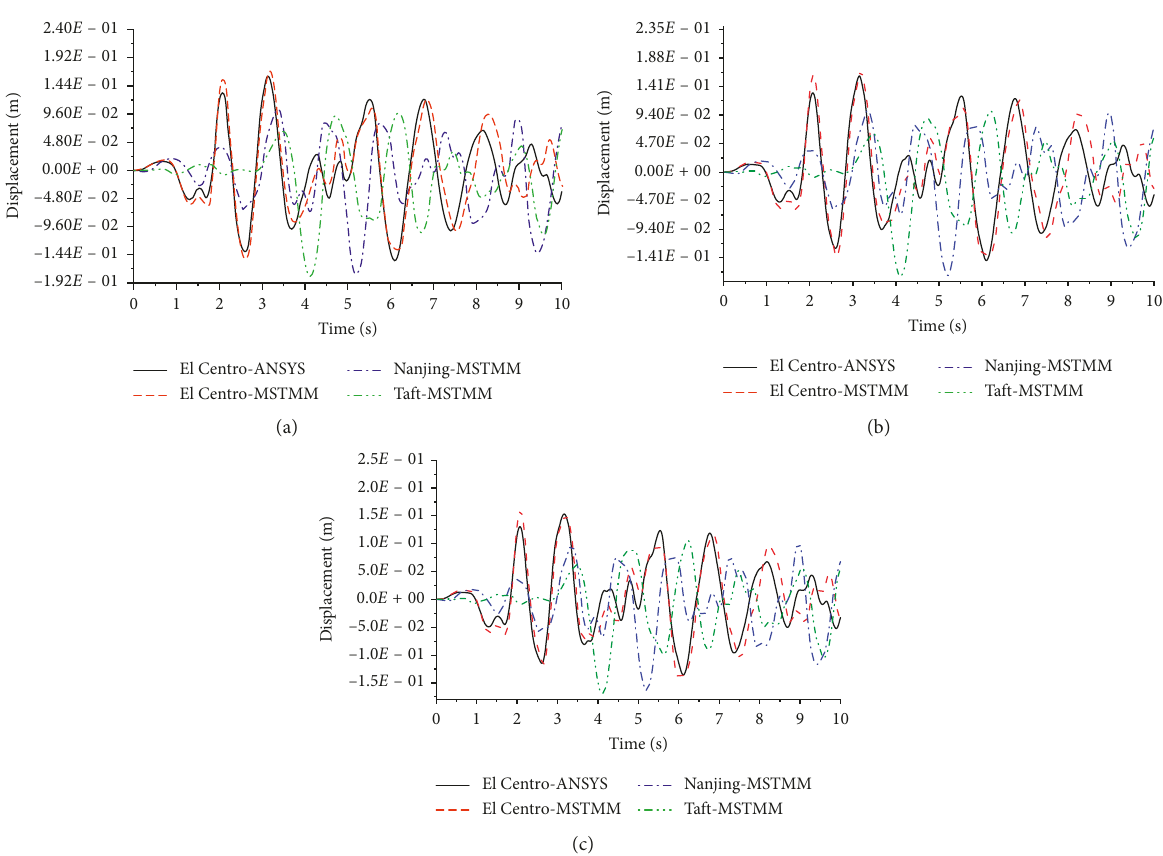
2 ). (a) 100mm,(b) 130 mm, and